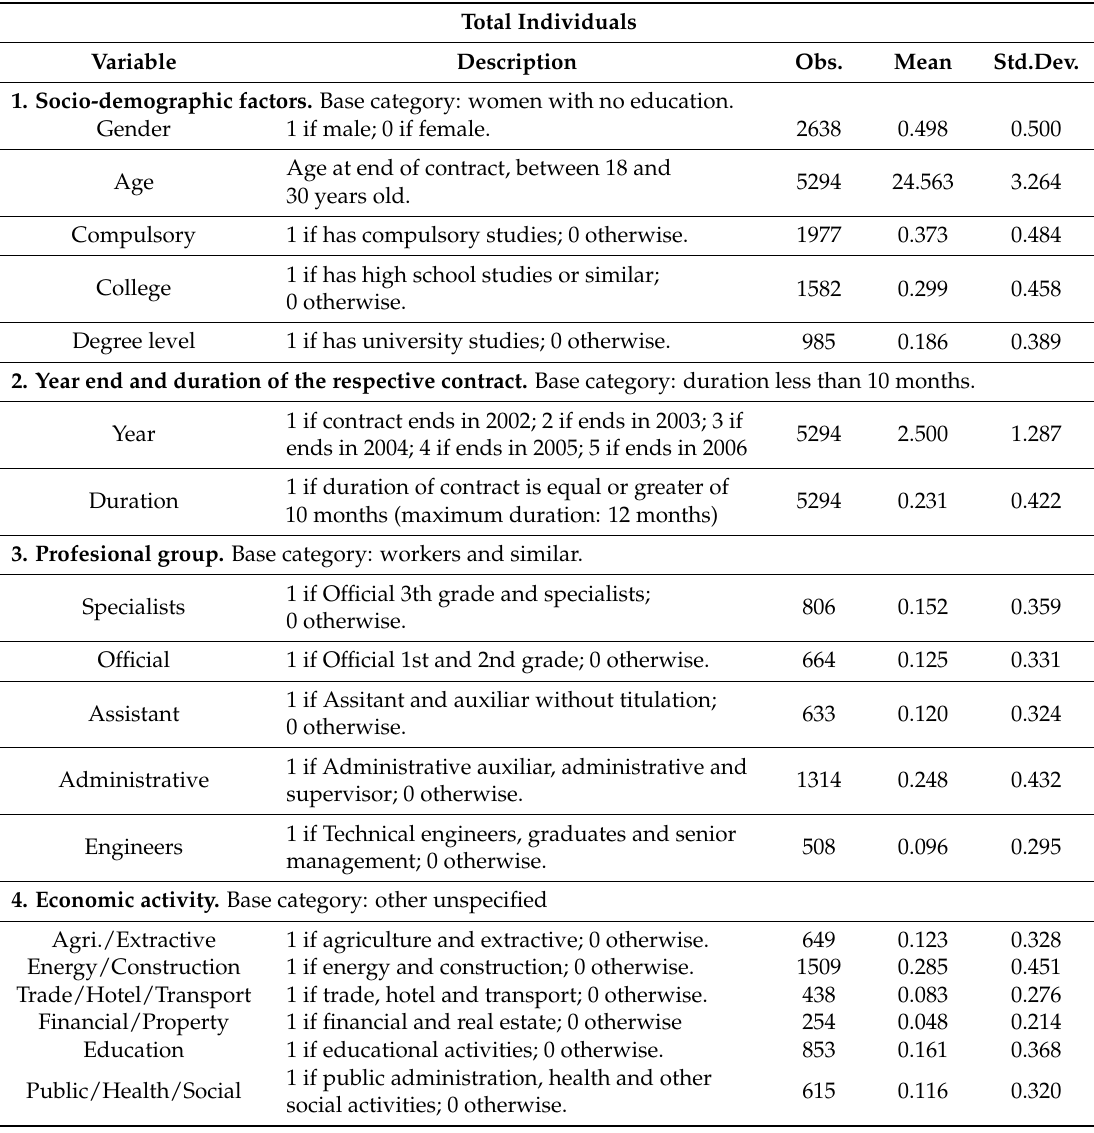
Table 1. Covariates and descriptive statistics: Total